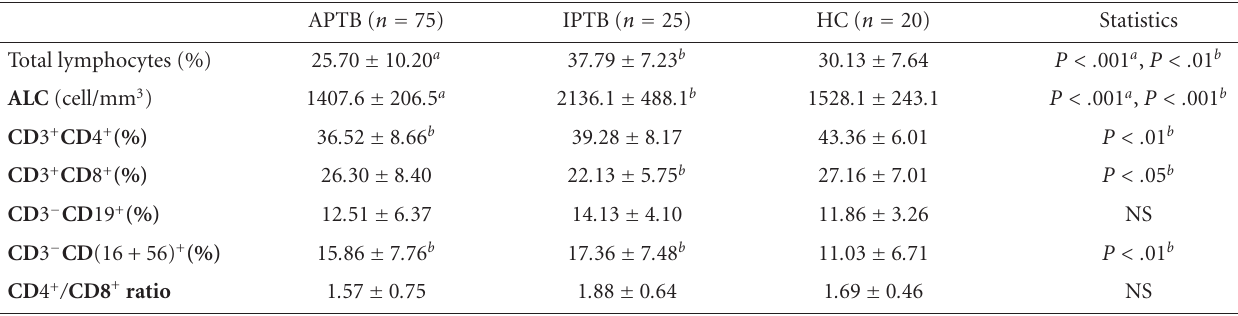
Table 1: The mean percentages of total lymphocytes, B-lymphocytes, T-lymphocyte subsets, CD3 − CD(16 + 56) + , and absolute lymphocyte counts in the study